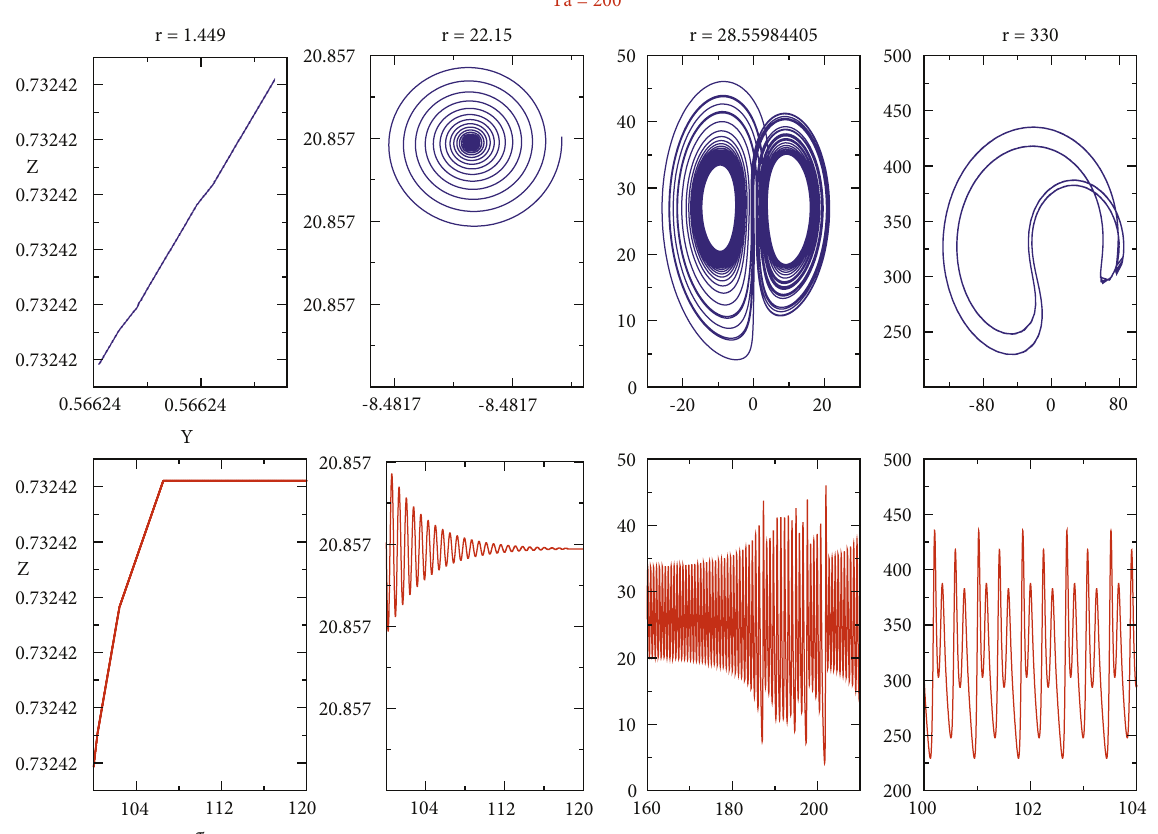
Figure 13: Phase portraits and time stories for various values of r when Ta � 200, Λ � 1, s � 0, Da � 1, P � 10, L � M � √ k � π / 2 , ε � 1, and σ � − 1/3